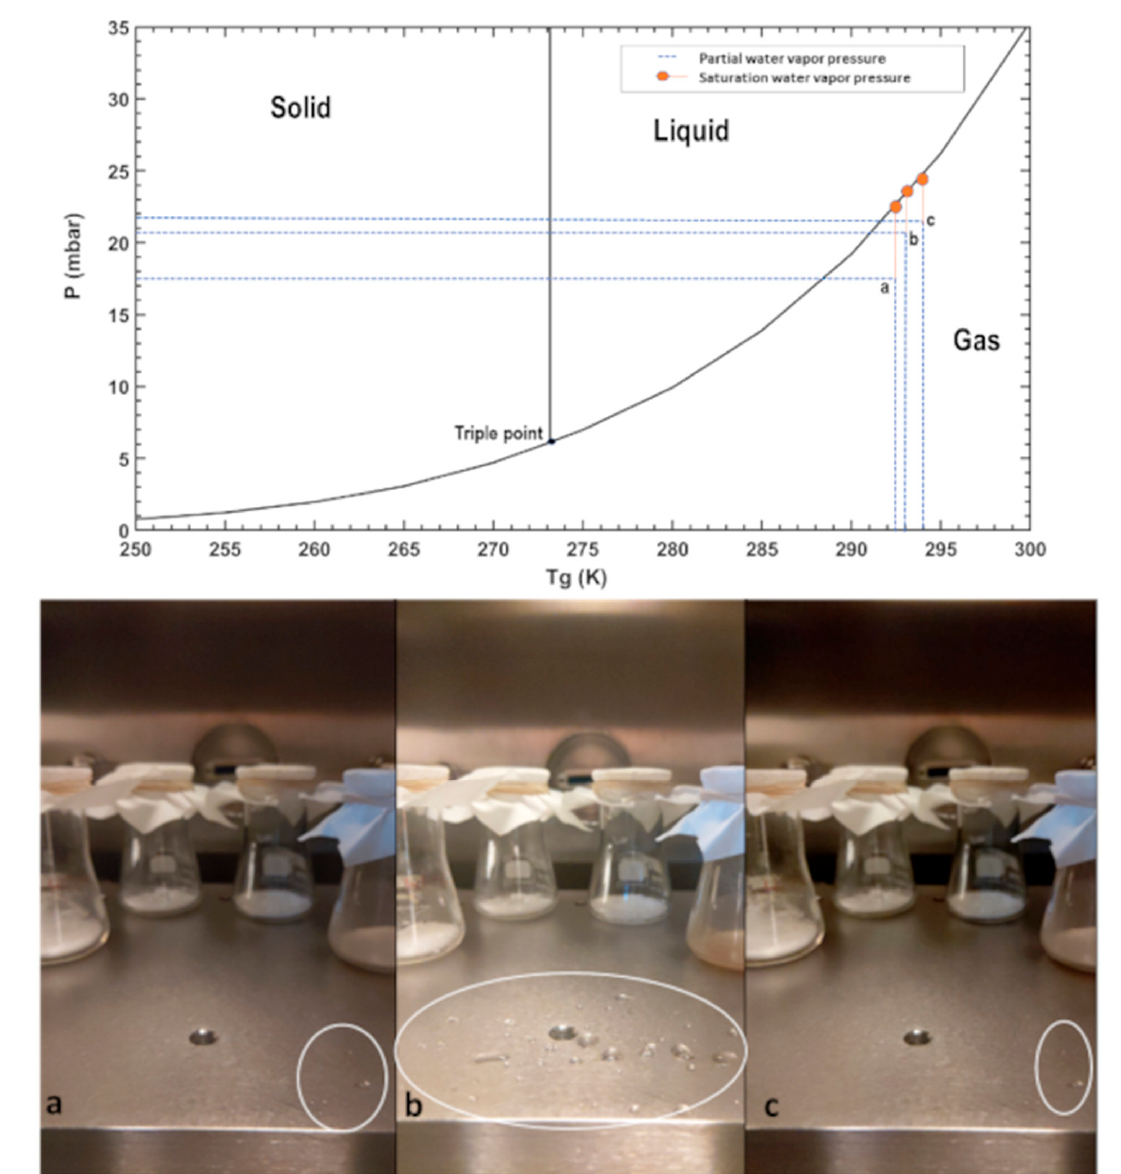
Figure 8. ( Top ) Environmental P, Tg conditions, during this experiment, the air and ground were in equilibrium, at almost saturated conditions, and the salts in the beakers were absorbing water. ( Bottom ) Images were taken as the water droplets formed inside the simulated Martian environment on the table. ( a ) As the water is injected at 292.6 K, the first few droplets start to form. ( b ) More droplets begin to form and be stable at 293 K. ( c ) These droplets persist for a period of one hour in the gas phase, and finally, the last droplet evaporated at 294 K.